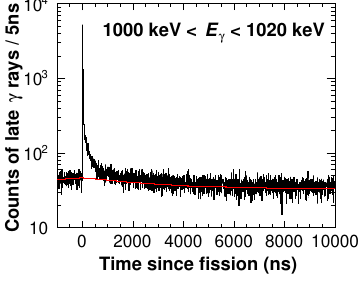
Figure 4. Measured t late − t prompt spectrum for γ rays between 1000 and 1020 keV compared with the calculated background. Fission occurred at t late − t prompt =